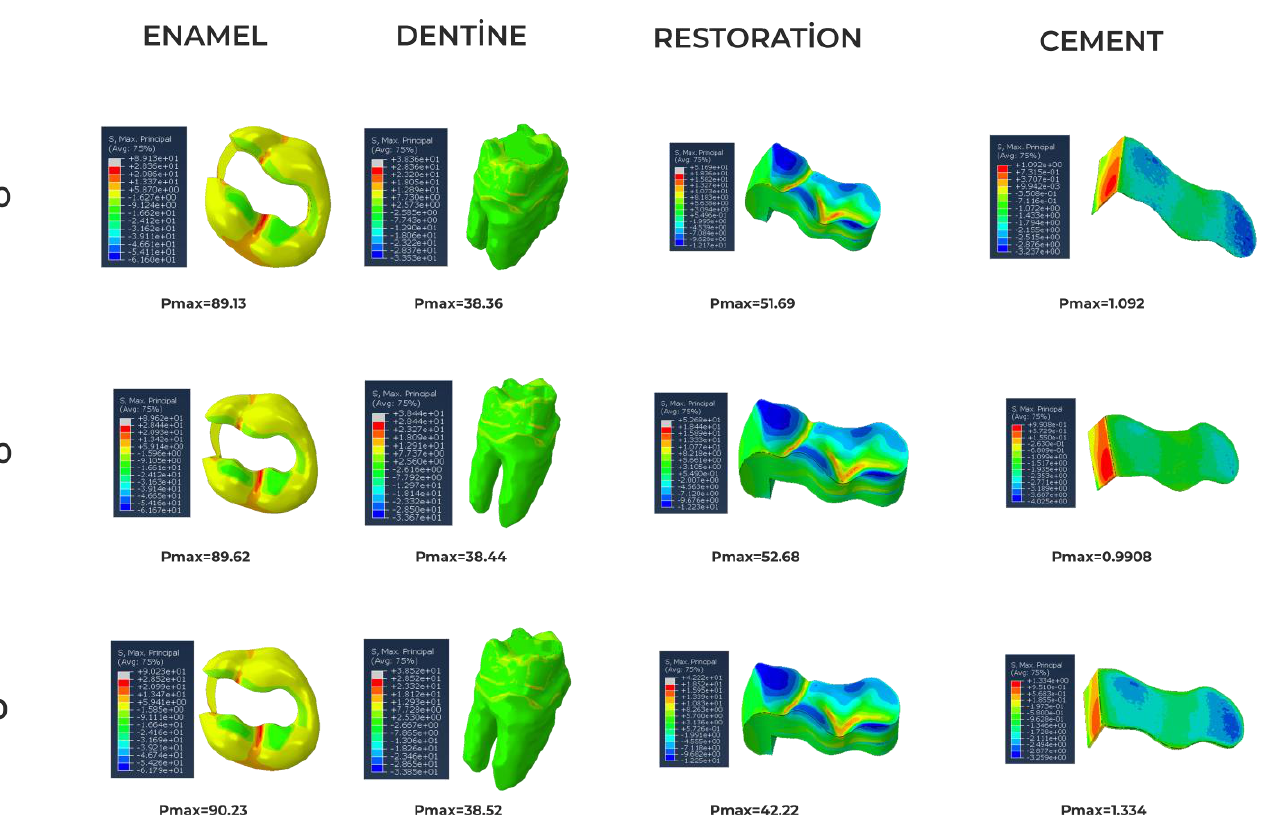
Figure 6. Maximum principal stress (MPa) distribution within the enamel, dentin, restoration, and different thicknesses of resin cement under 600 N of total force applied to the occlusal surface (V1; Poisson’s ratio: 0.35 ) with the amalgam.